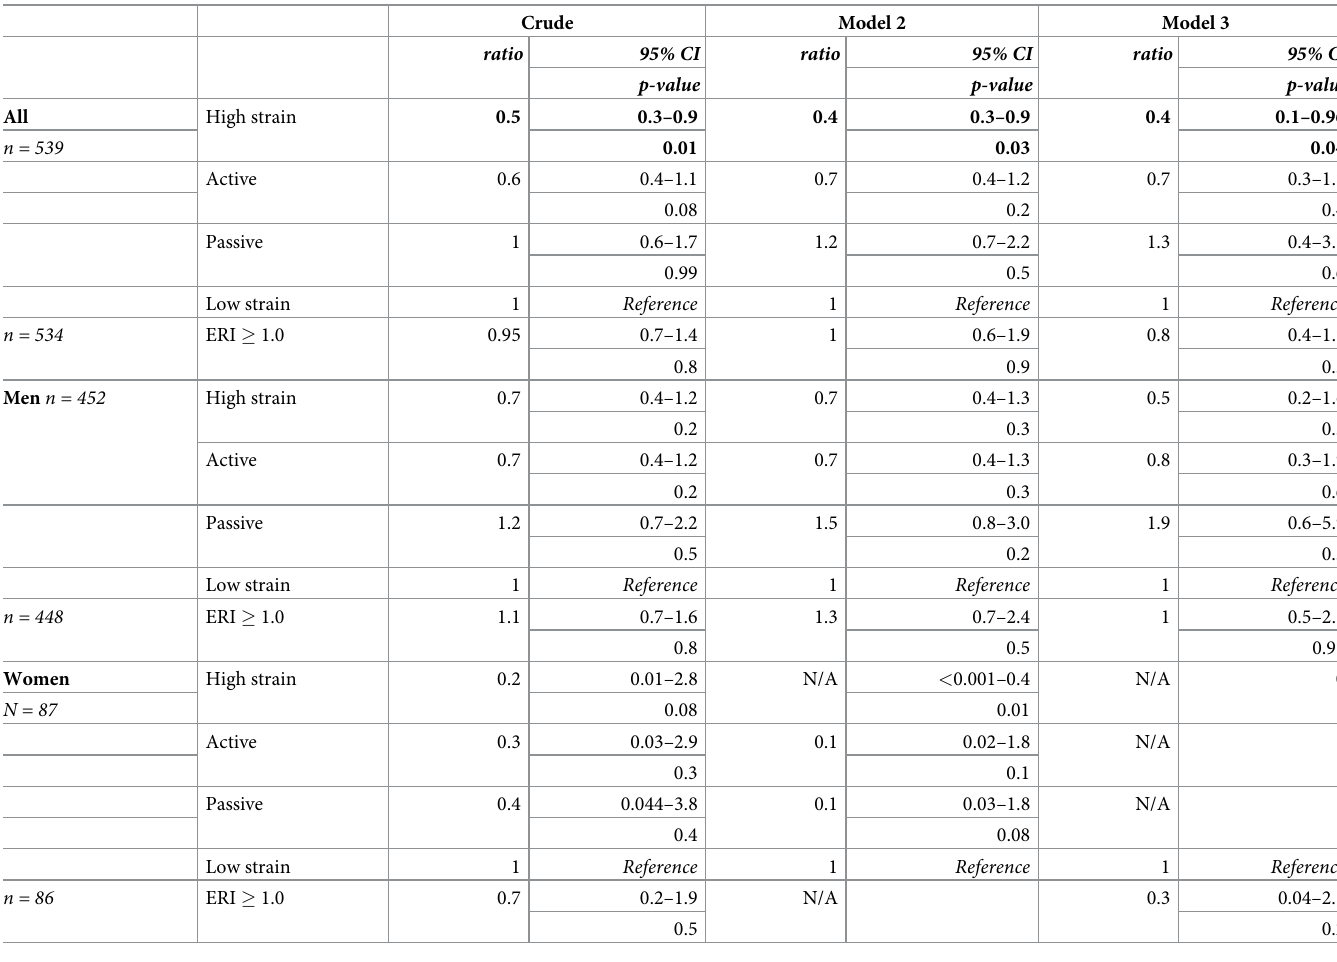
Table 3. Regression analyses of psychosocial conditions between cases with extended work � 63 years and controls who retired � 62 years in blue-collar